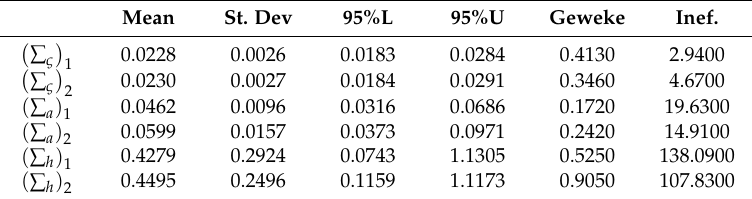
Table 6. Estimation of selected parameters in the TVP-VAR model (real estate development loans–housing prices).